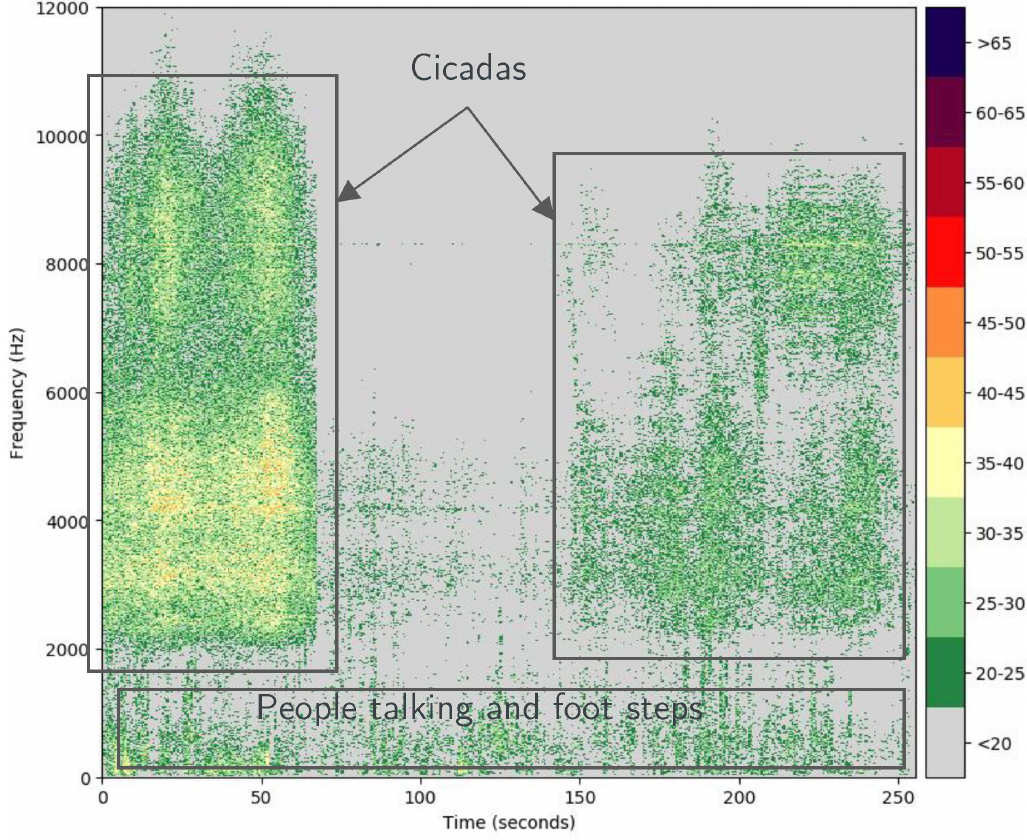
Figure 6: The spectrogram of the Soundscape from the main entrance opposite the train station to the starting of the path lined with thou- sands of